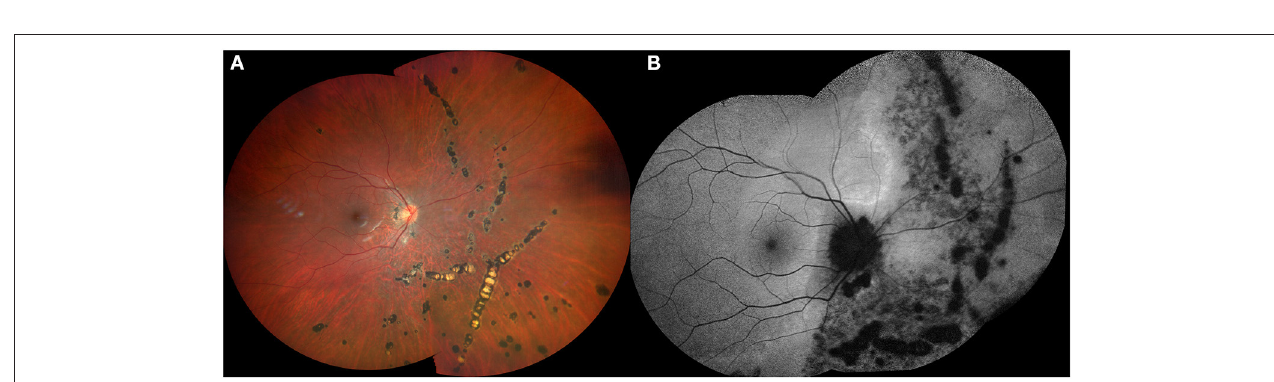
FIGURE 2 | Illustrative examples of atrophic chorioretinal changes in patients with multifocal choroiditis (MFC). Top row shows cases with multifocal small rounded atrophic lesions in patients with recent diagnosis of MFC. Bottom row shows long standing MFC cases with larger and more profound chorioretinal atrophic changes associating eventual pigmentation of the margins.